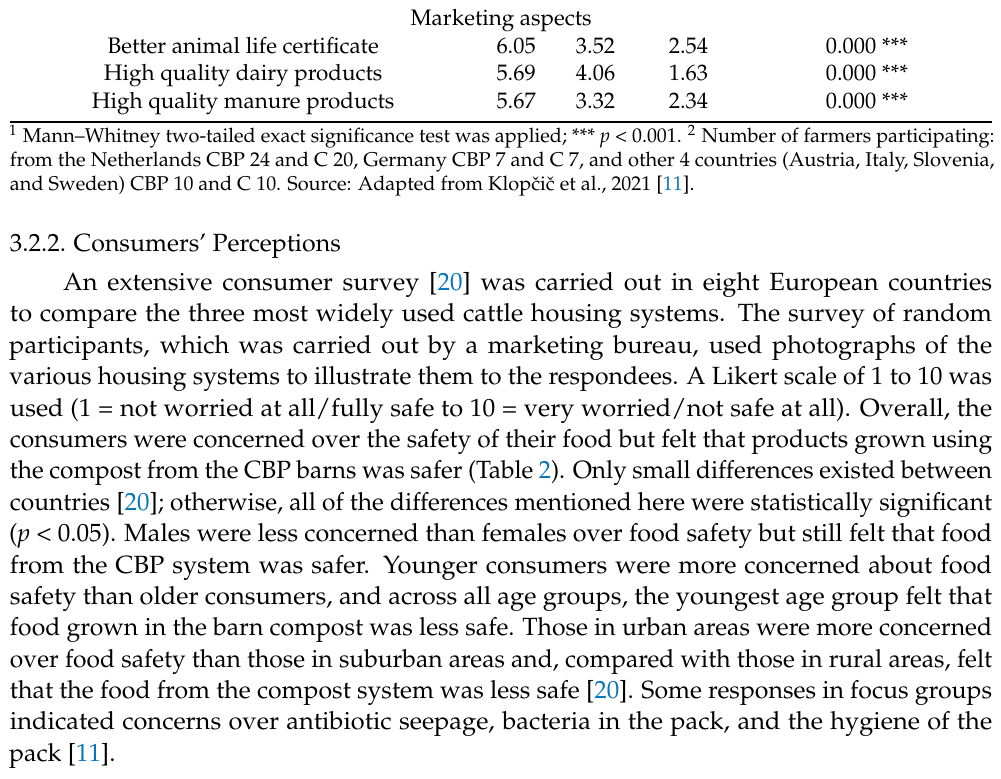
Bedding material and slurry as soil